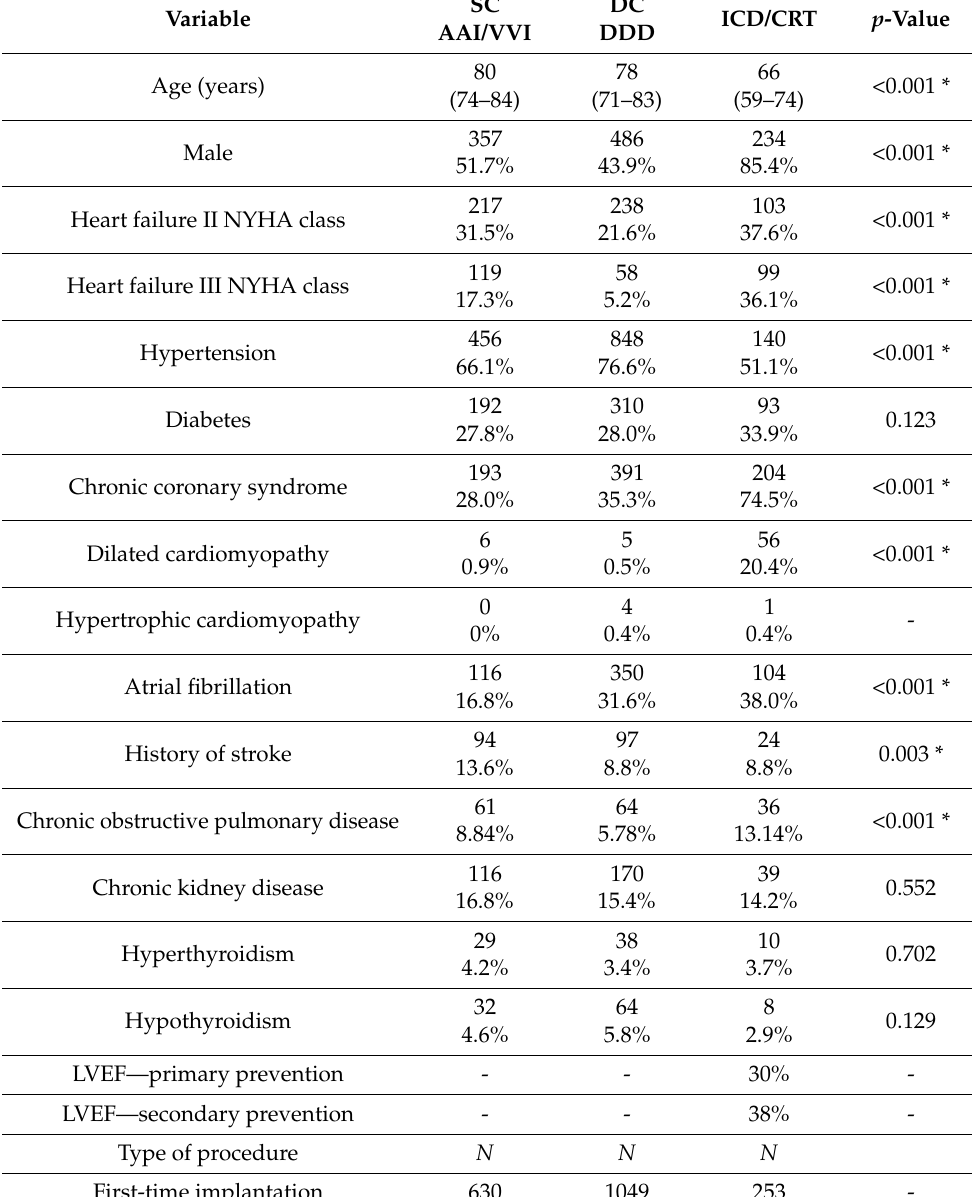
Table 1. The examined patients’ characteristics, divided by the type of device (implanted data presented as numbers and